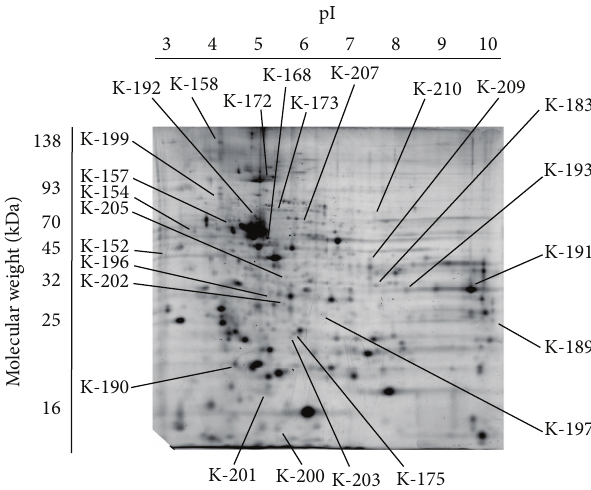
Figure 1: Photographs of a two-dimensional electrophoresis gel with annotation of the spots of identified proteins. The image shows a silver-stained gel of rat retina after TES. The proteins spots that wereincreasedordecreasedwithorwithoutTESthatwereidentified by PMF are shown. Spots K-152 to K-210 represent the annotated spots. The pH gradient of the first dimension electrophoresis is shown at the top of the gels, and the migration of the molecular mass markers for SDS-PAGE in the second dimension is shown at the side of the gel. Representative gel images are